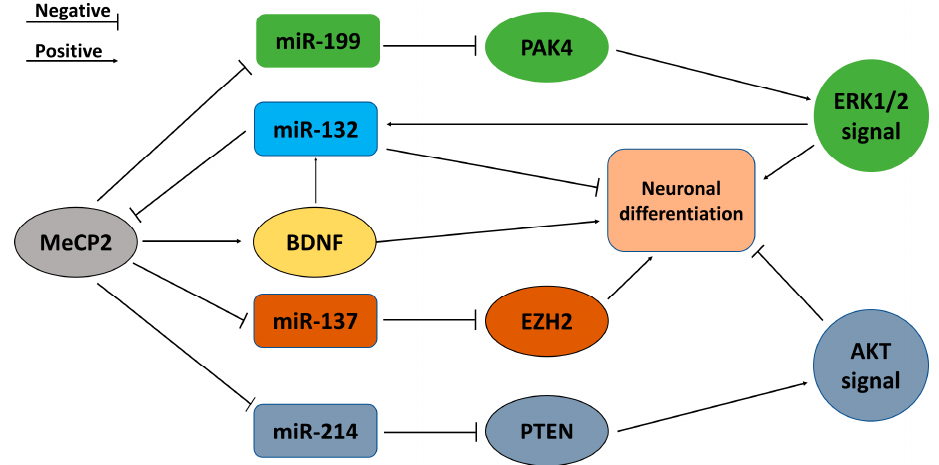
Figure 1. The feedback loops of miRNAs regulated by MeCP2 promoting or repressing neuronal differentiation.